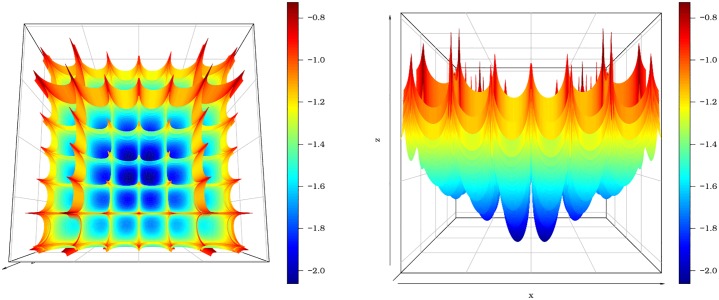
Cross-in-tray function from two different angles.